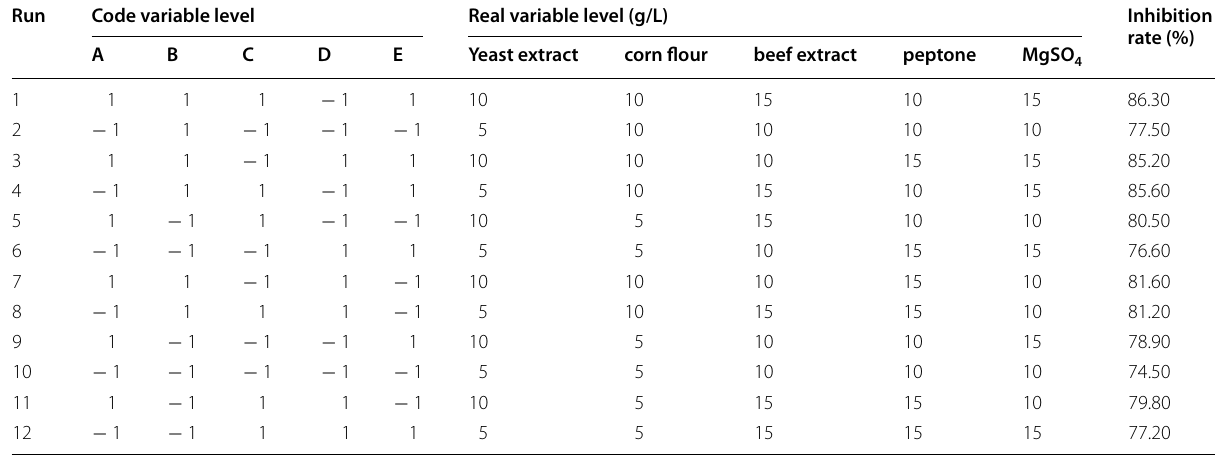
Table 1 Experimental matrix and response values from randomized runs in the Packett‑Burman test Run Code variable